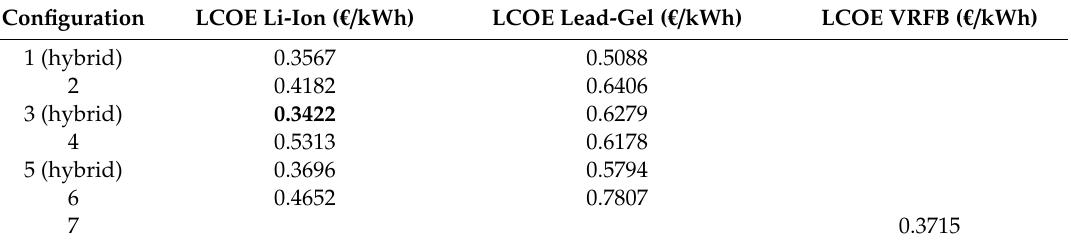
Table 9. LCOE related to the di ff erent investigated configurations— L Kit load profile. Configuration